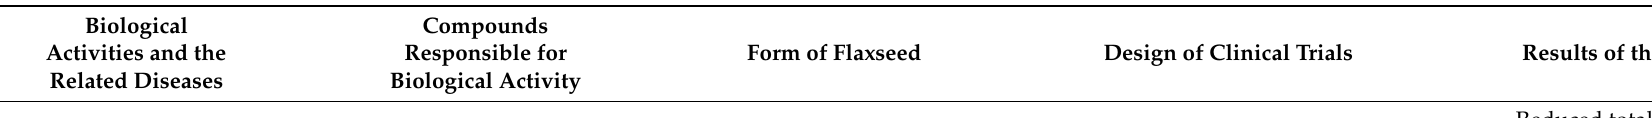
Table 1. The biological activities of flaxseed and its health-promoting